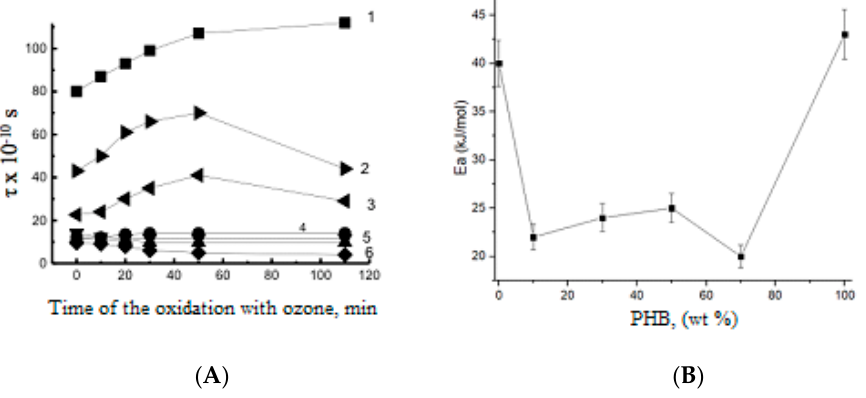
Figure 7. ( A ) The TEMPO correlation time ( τ ) for the PHB-PLA fibrous mats at different times of ozonation. Polymer ratio—PHB:PLA (wt.%): 1—100:0, 2—0:100, 3—70:30, 4—50:50, 5—30:70, 6—10:90. ( B ) The energy activation of TEMPO probe mobility in the fibrous blends of PHB and PLA.